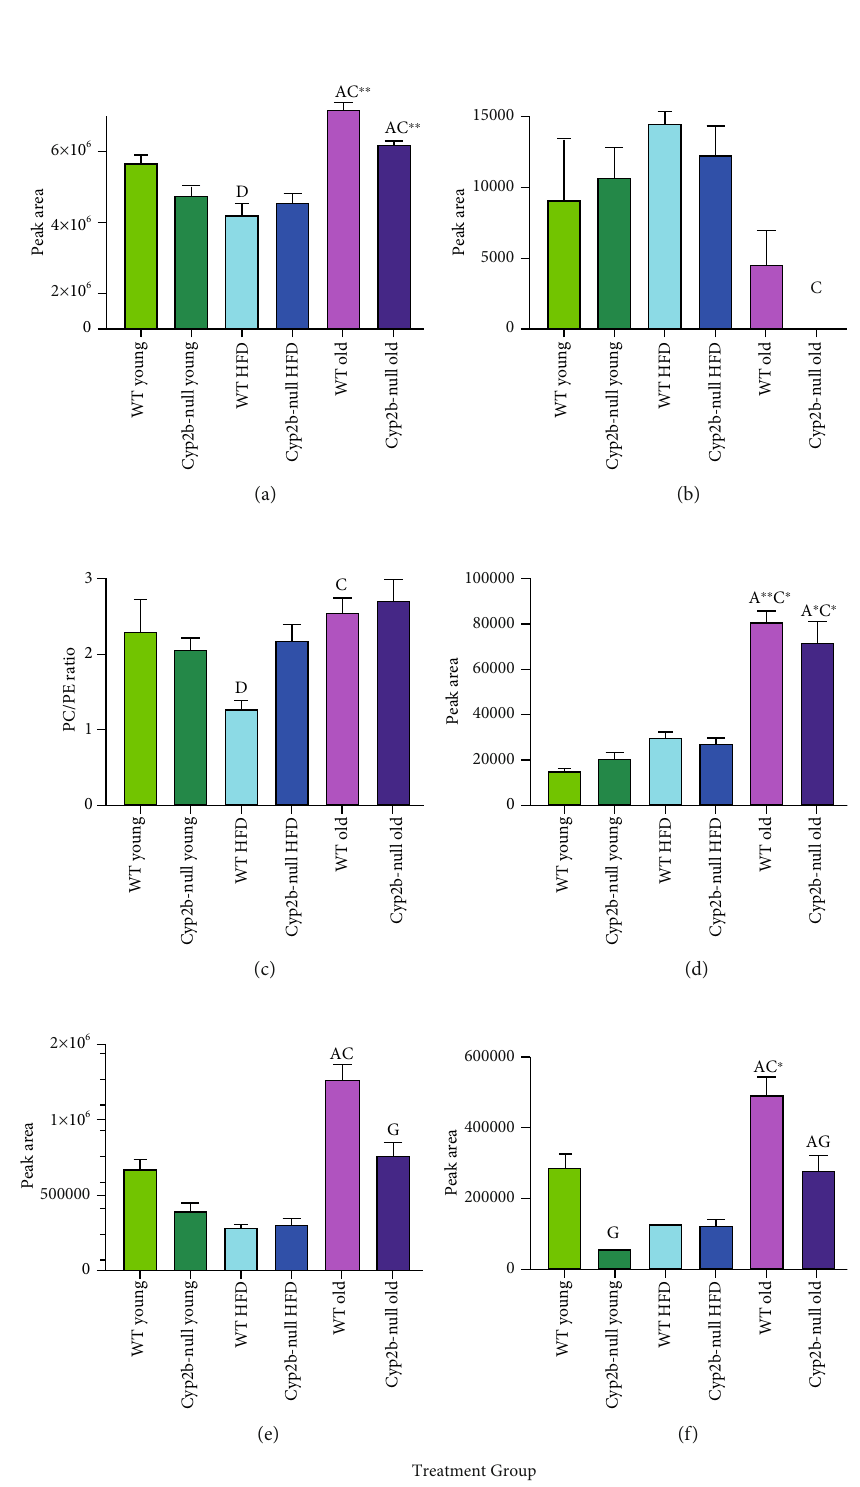
Figure 6: Comparison of distinct lipid groups or ratios between treatment groups. Total lipids, speci fi c ratios, and lipid species were compared between all treatment groups: Total phospholipids (a), phosphatidylethanolamine 38 :6 (b), total phosphatidylcholines/ phosphatidylethanolamines ratio (c), phosphatidylcholine 34:3 (d), total lysophosphatidylcholines (e), and lysophosphatidylcholine 18:2 (f). Data are presented as mean ð g Þ ± SEM . Statistical signi fi cance was determined by one-way ANOVA multiple comparison test with Tukey ’ s as the post hoc test ( n = 3 − 5 ). “ a ” indicates age di ff erence between young (4.5 mo) and old (9 mo) mice within same genotype and diet group, “ c ” indicates di ff erence between HFD-fed young (4.5 mo) and ND-fed old (9 mo) mice within same genotype, “ d ” indicates diet di ff erence between ND-fed and HFD-fed mice within in same genotype and age, and “ g ” indicates genotype di ff erence between WT and Cyp2b-null mice within same diet and age group. No asterisk indicates a p value < 0.05, ∗ indicates a p -value < 0.01, and ∗∗ indicates a p values <